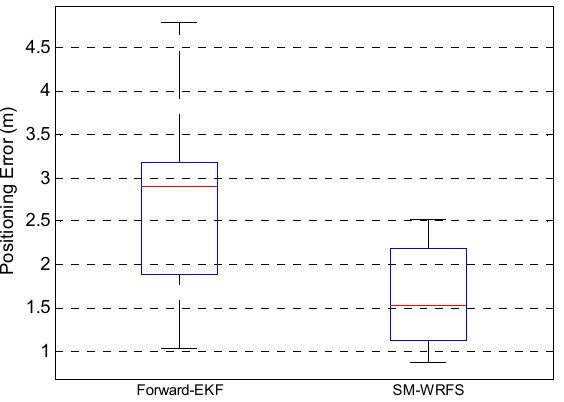
Figure 13. Positioning Errors Comparison.